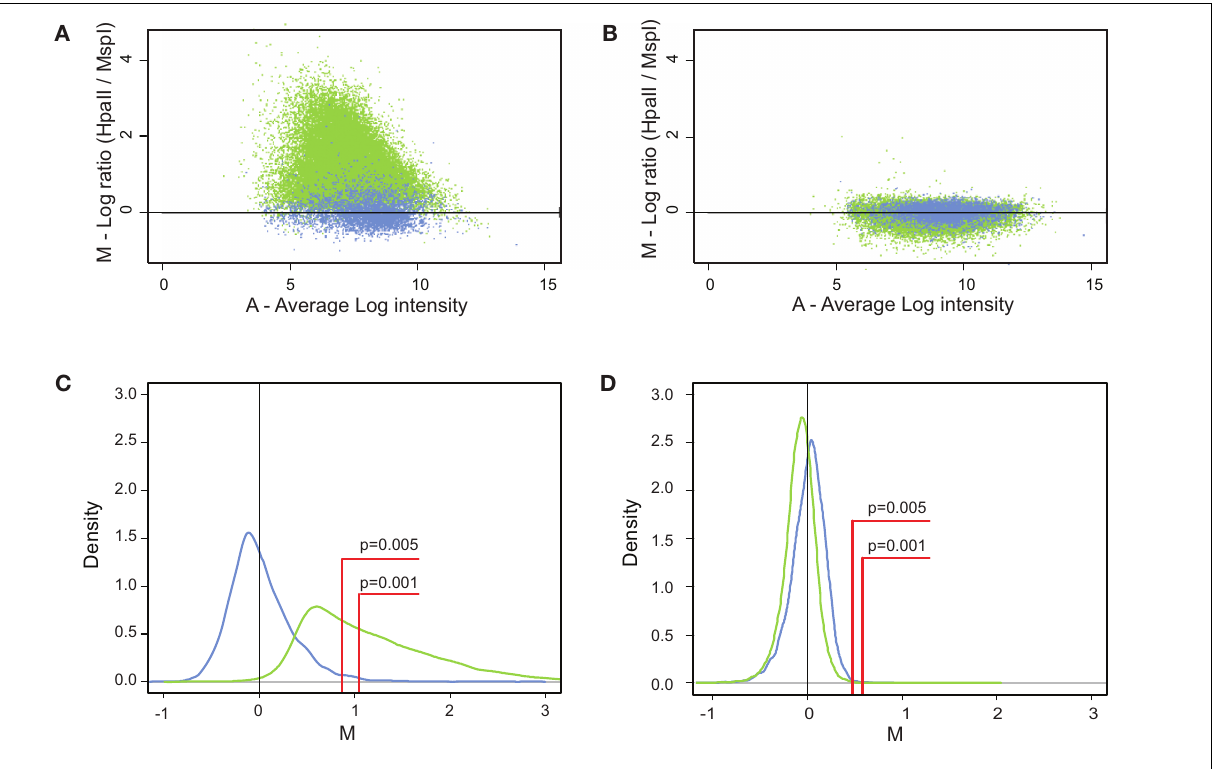
FIGURE 2 | MSRE analysis of SssI treated and whole-genome amplifi ed (C) M -value density plot of SssI-treated DNA. The blue curve represents density normal human brain DNA samples. (A) MA plot (log ratio vs. average log of M values for insensitive fragments, and the green curve represents density of 2 intensity of both channels) of SssI-treated (completely methylated) normal brain M values for sensitive fragments. Area under both curves has been normalized DNA. Each dot represents average data from two experiments for a single to 100%. The ‘sensitive’ fragment curve is shifted to the right of the ‘insensitive’ fragment calculated based on the data from all available probes binding to that fragment curve. p ≤ 0.005 and p ≤ 0.001 thresholds are indicated by red lines fragment (Materials and Methods). Insensitive fragments are shown in blue and calculated relative to median of insensitive fragments (black vertical line). The sensitive fragments in green. (B) MA plot of whole-genome amplifi ed area under the green curve to the right of the red line represents methylated (completely unmethylated) DNA. Average data from two experiments is plotted fragments by MSRE analysis. (D) M -value density plot of whole-genome as in (A) showing signifi cantly lower M values compared to SssI treated DNA. amplifi ed DNA. Sensitive and insensitive curves are closely